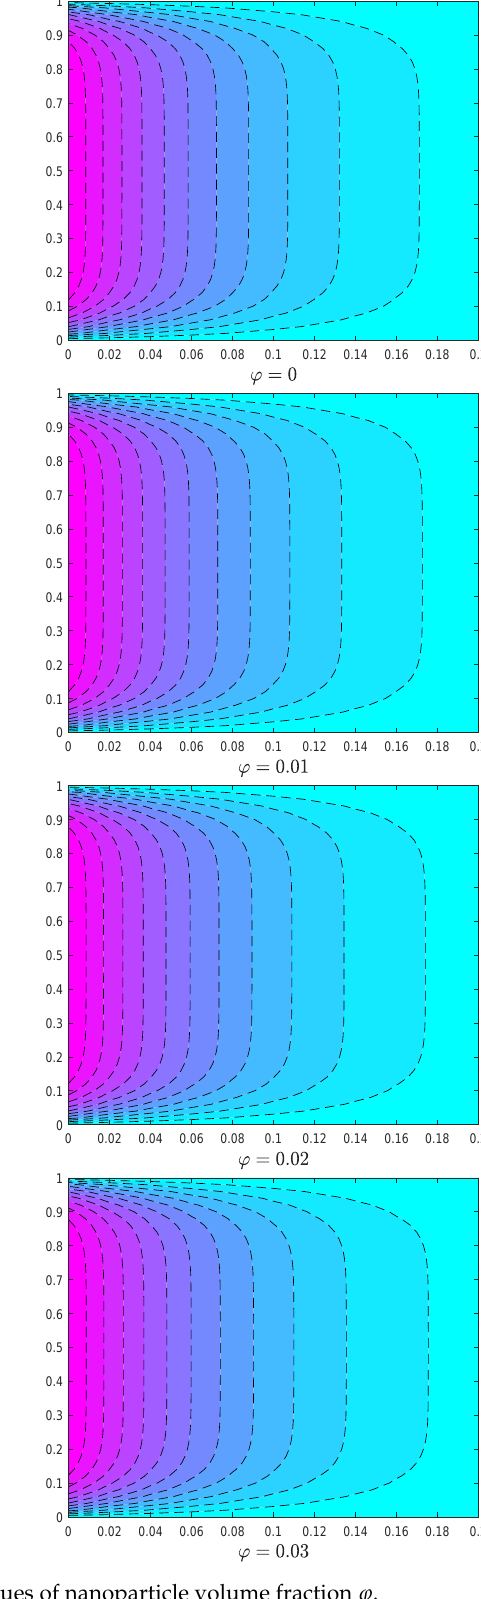
Figure 6. Temperature profile for different values of nanoparticle volume fraction ϕ